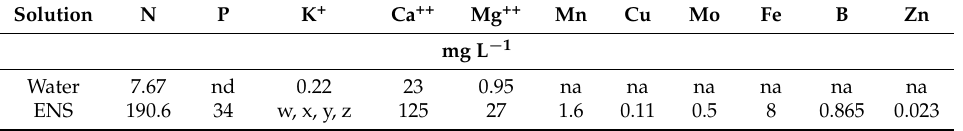
Table 2. Chemical composition of the experimental solution and used water for